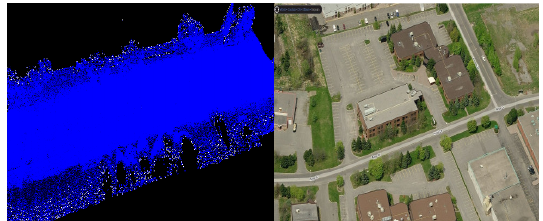
Figure 2. Auriga Dr dataset. Left: Input point cloud. Right: www.bing.com.